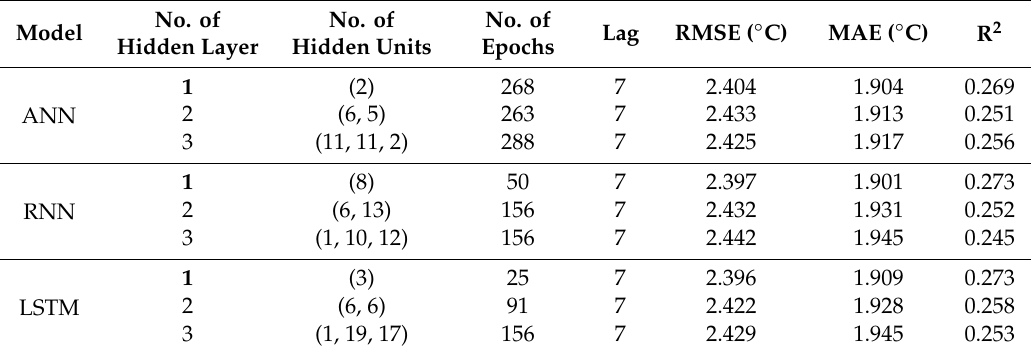
Table 4. The performance measure of models for